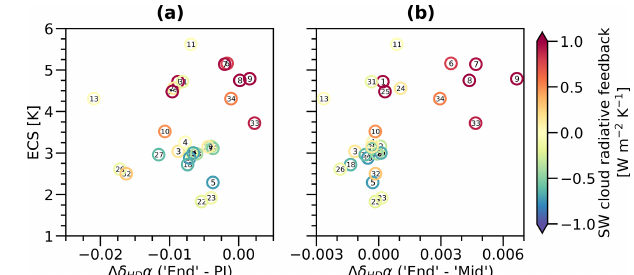
Figure 7. Estimates of ECS plotted against the (a) End minus PI and (b) End minus Mid albedo asymmetry anomaly (cid:49)δ HD α . Esti- mates of model SW cloud radiative feedback strengths are given by the color of the marker. Markers denote models as they are num- bered in Table